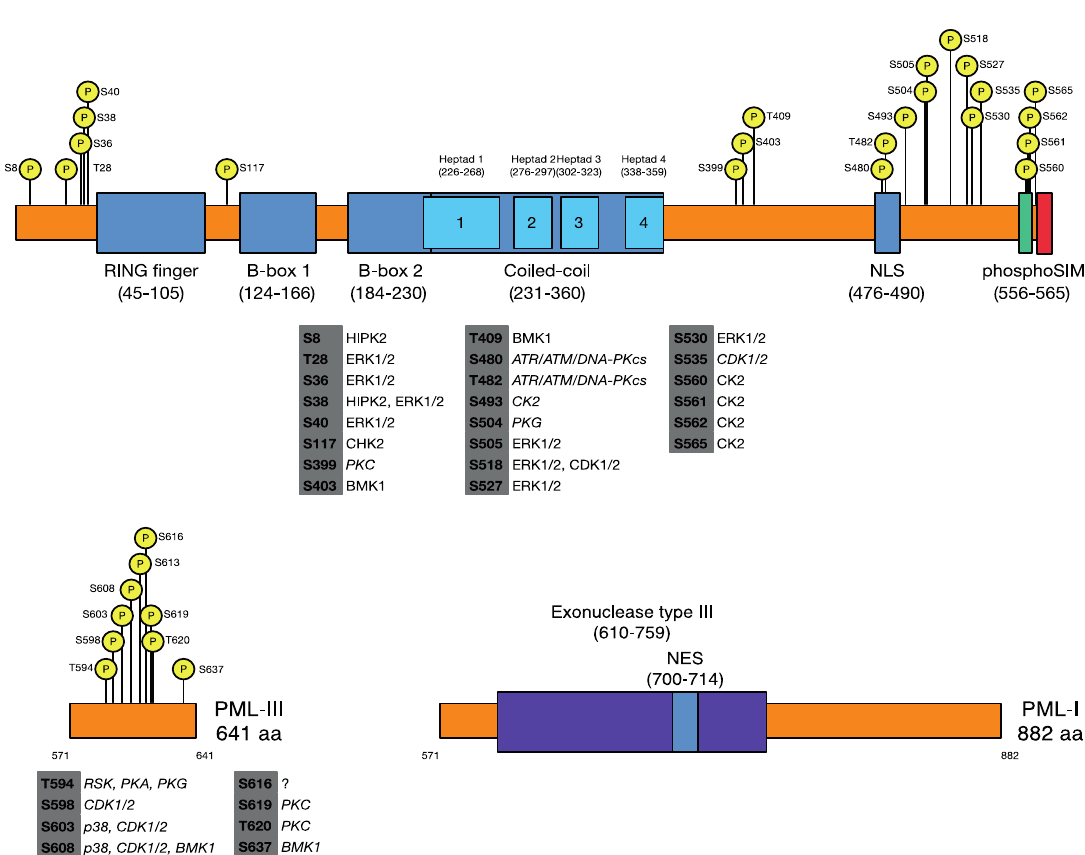
Figure 1. Map of known and novel sites of promyelocytic leukemia (PML)